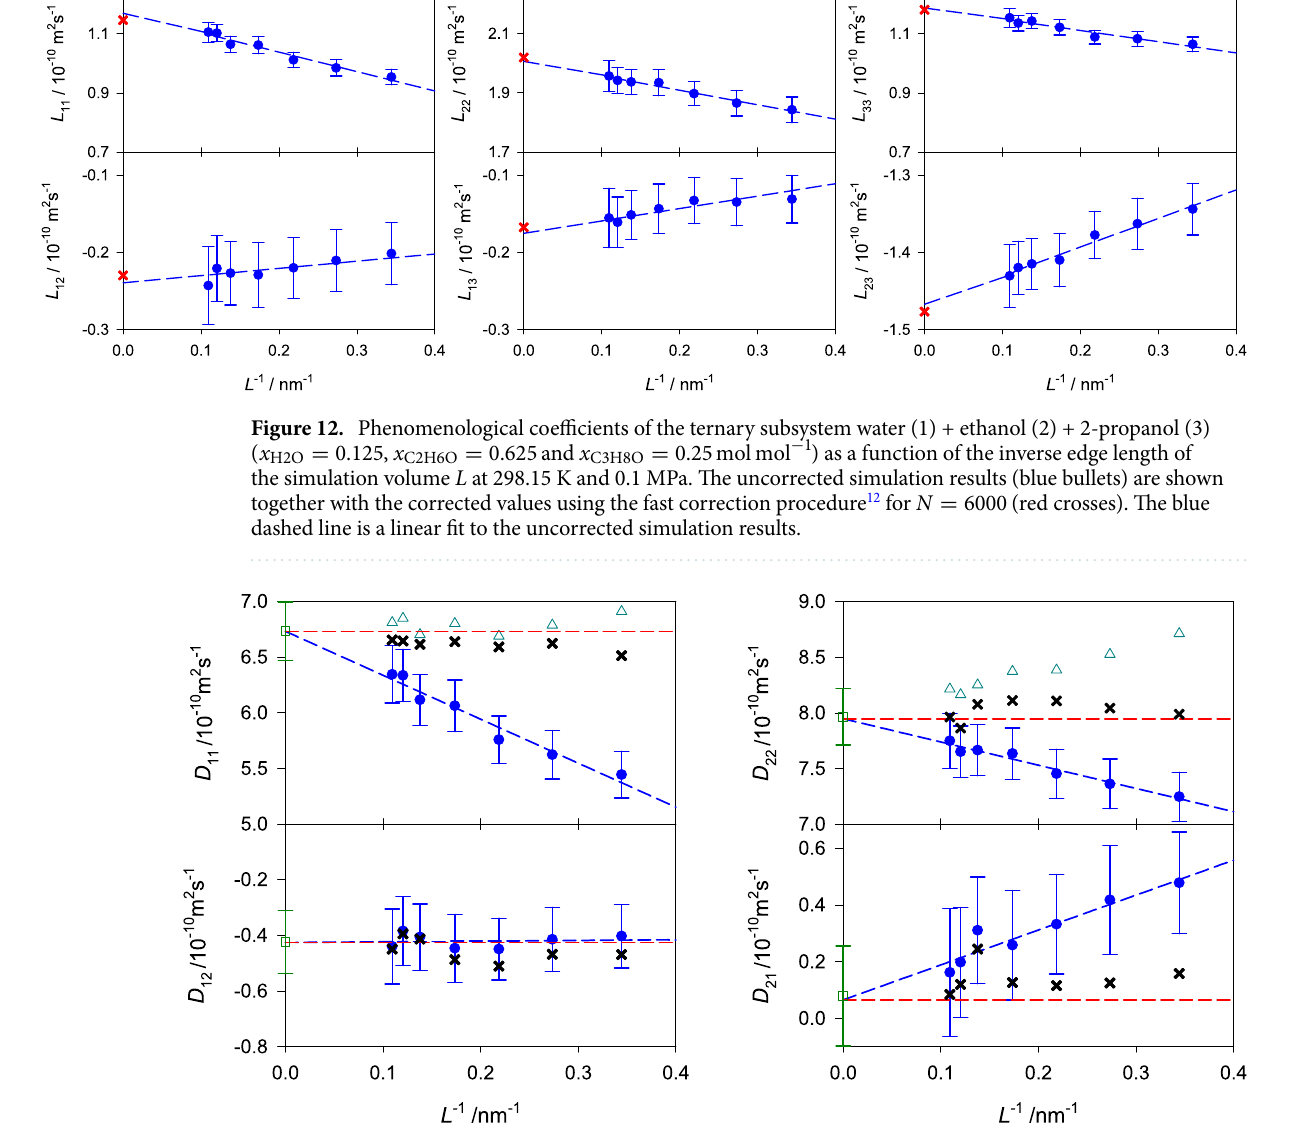
1 ) as a function of the inverse edge